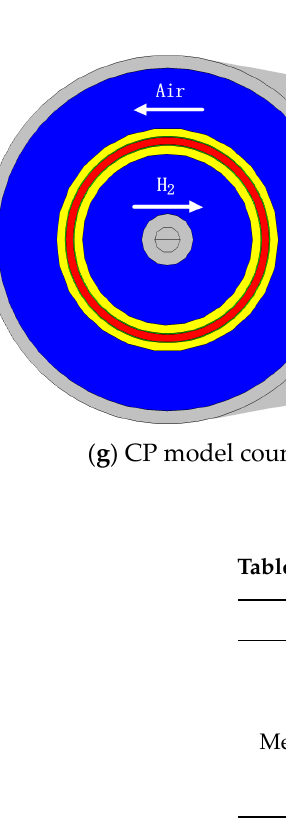
Table 2. Operating conditions and electrochemical parameters.